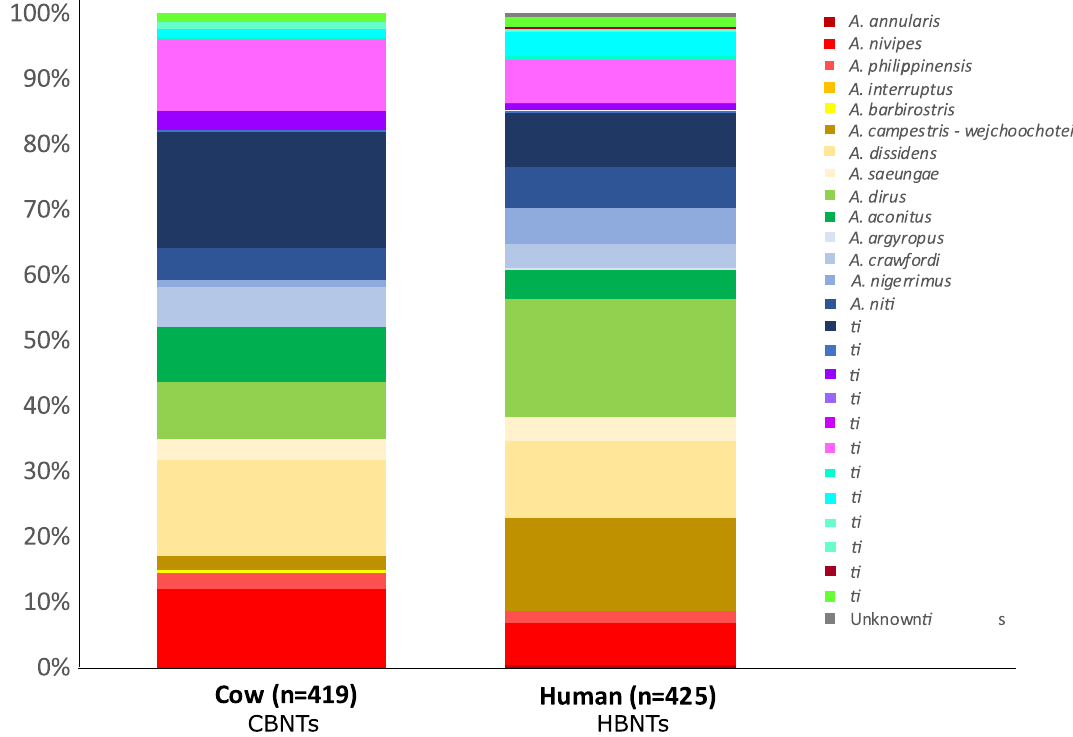
Figure 5. Proportions of the molecularly identified samples in the CBNTS and